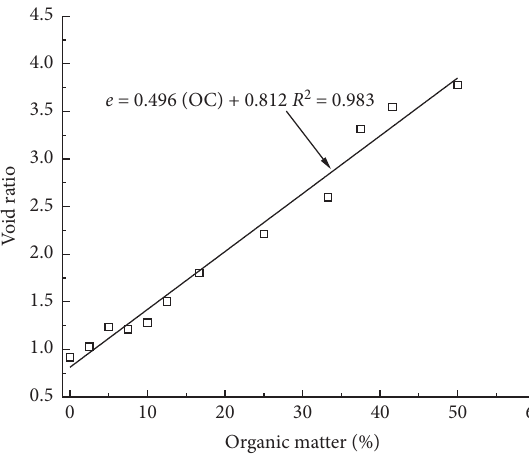
Figure 4: Change of specific gravity against organic matter